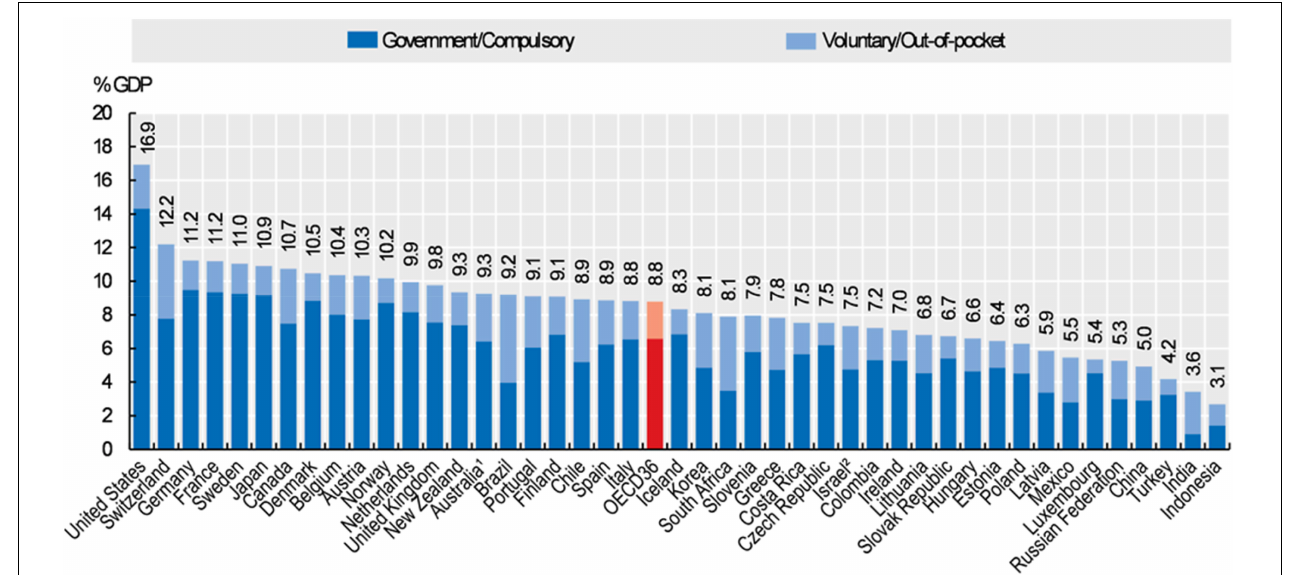
FIGURE 4 | Health expenditures as a proportion of the Gross Domestic Product (GDP) in 2019. Source: 2019 OECD Health Statistics; WHO Global Health Expenditure